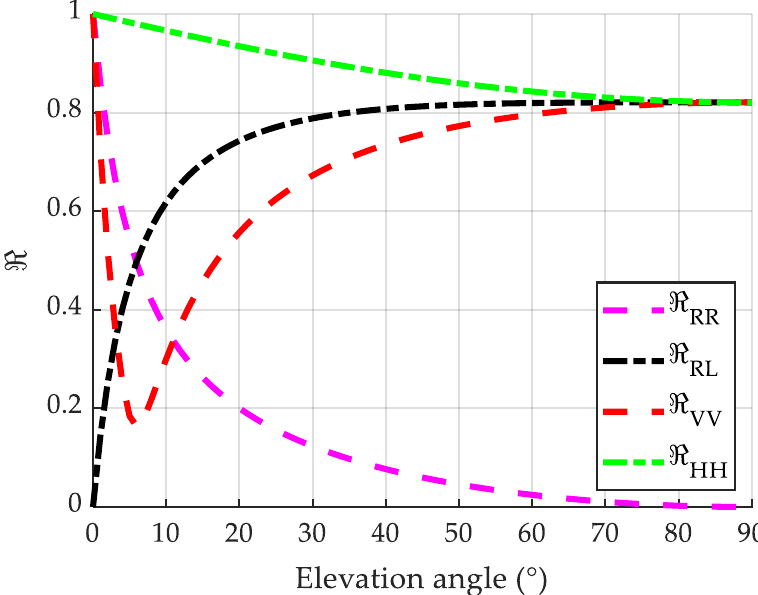
Figure 2. The relationship between the Fresnel reflection coefficient of sea water and the change of elevation angle.